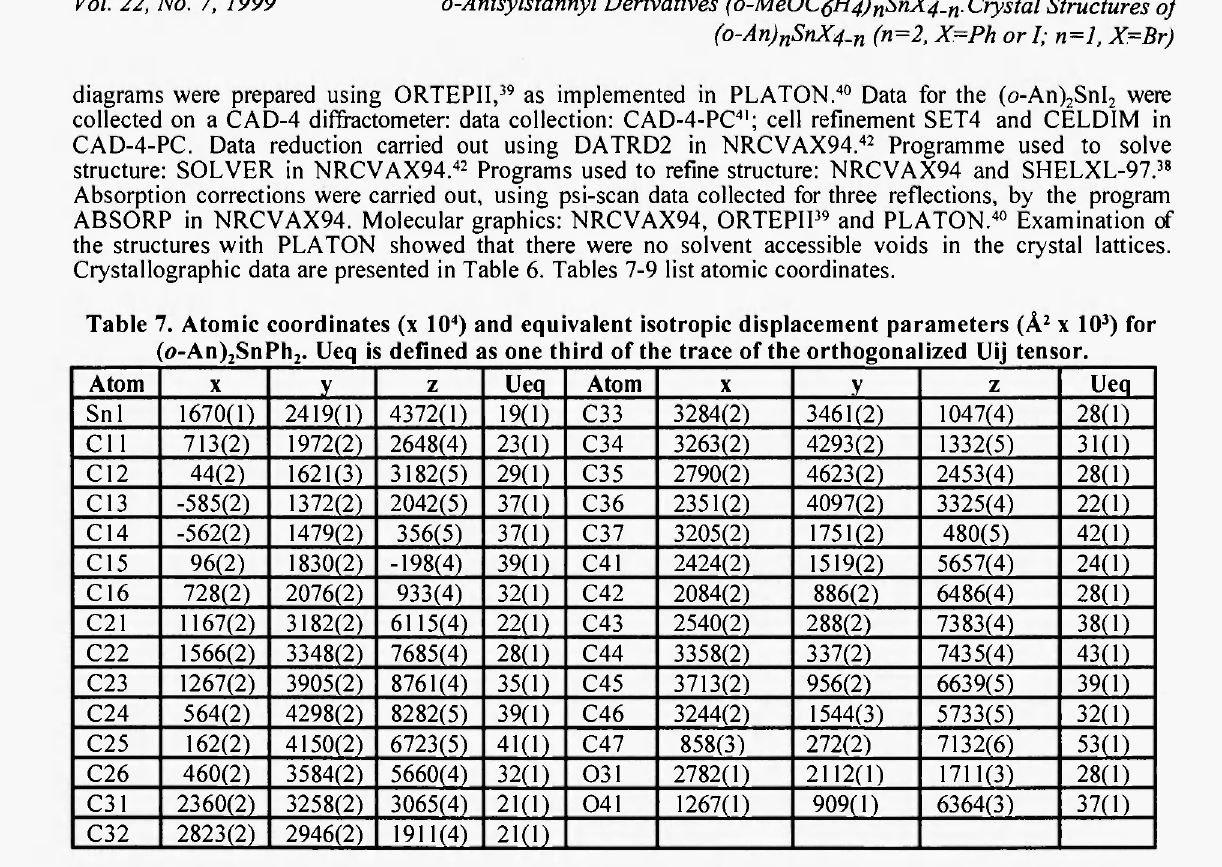
Table 8. Atomic coordinates (χ 10 4 ) and equivalent isotropic displacement parameters (Ä 2 χ ΙΟ 3 ) for (o-An) 2 SnI 2 . Ueq is defined as one third of the trace of the orthogonalized Uij tensor.